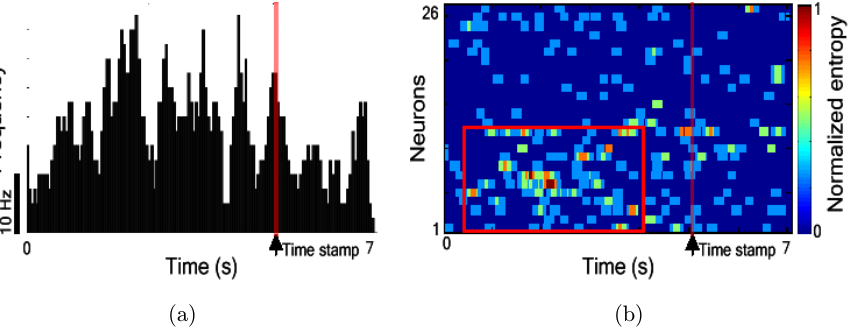
Fig. 3. Neuronal ensemble entropy coding during the working memory task. (a) Histogram of neuronal population ¯ring. (b) Neuronal ensemble entropy coding.